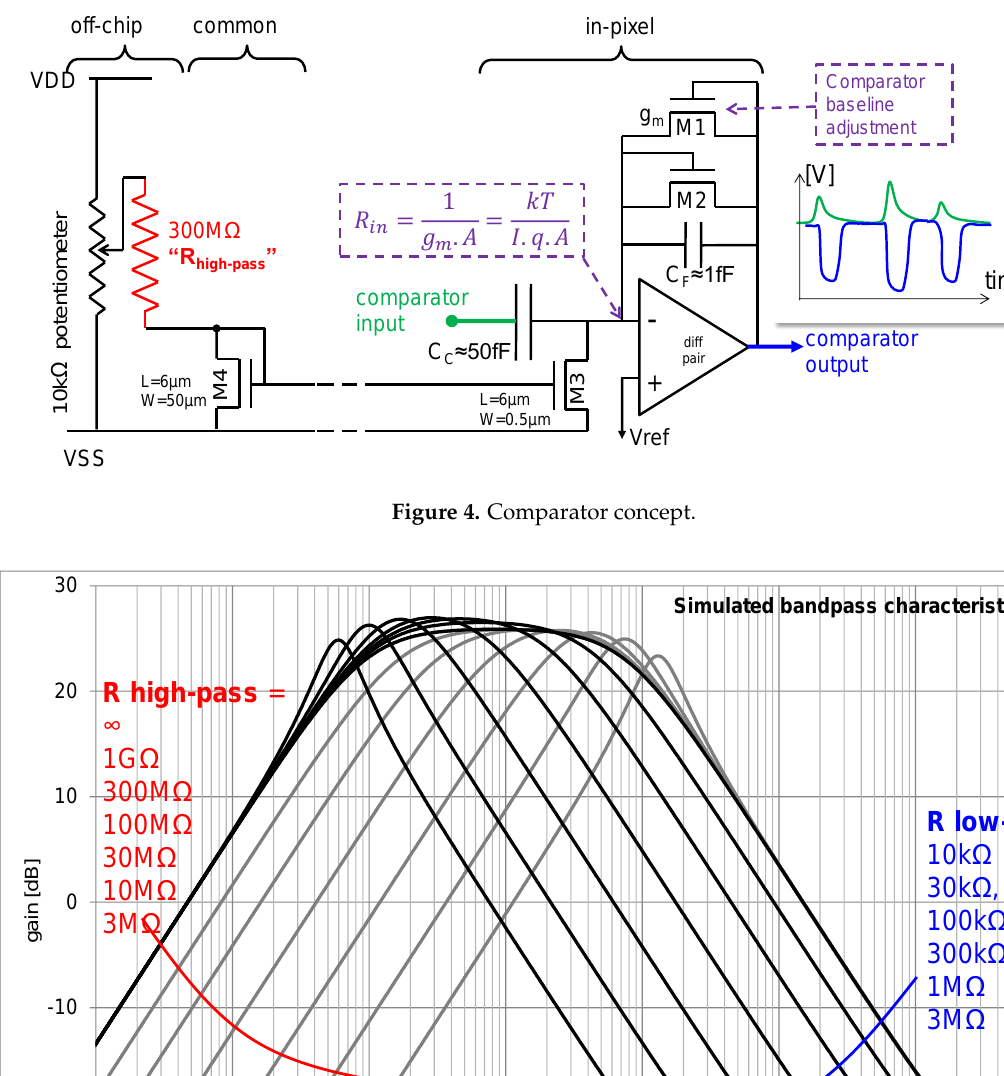
Figure 5. Simulated bandpass characteristics of the combination of pulse -shaper and comparator.